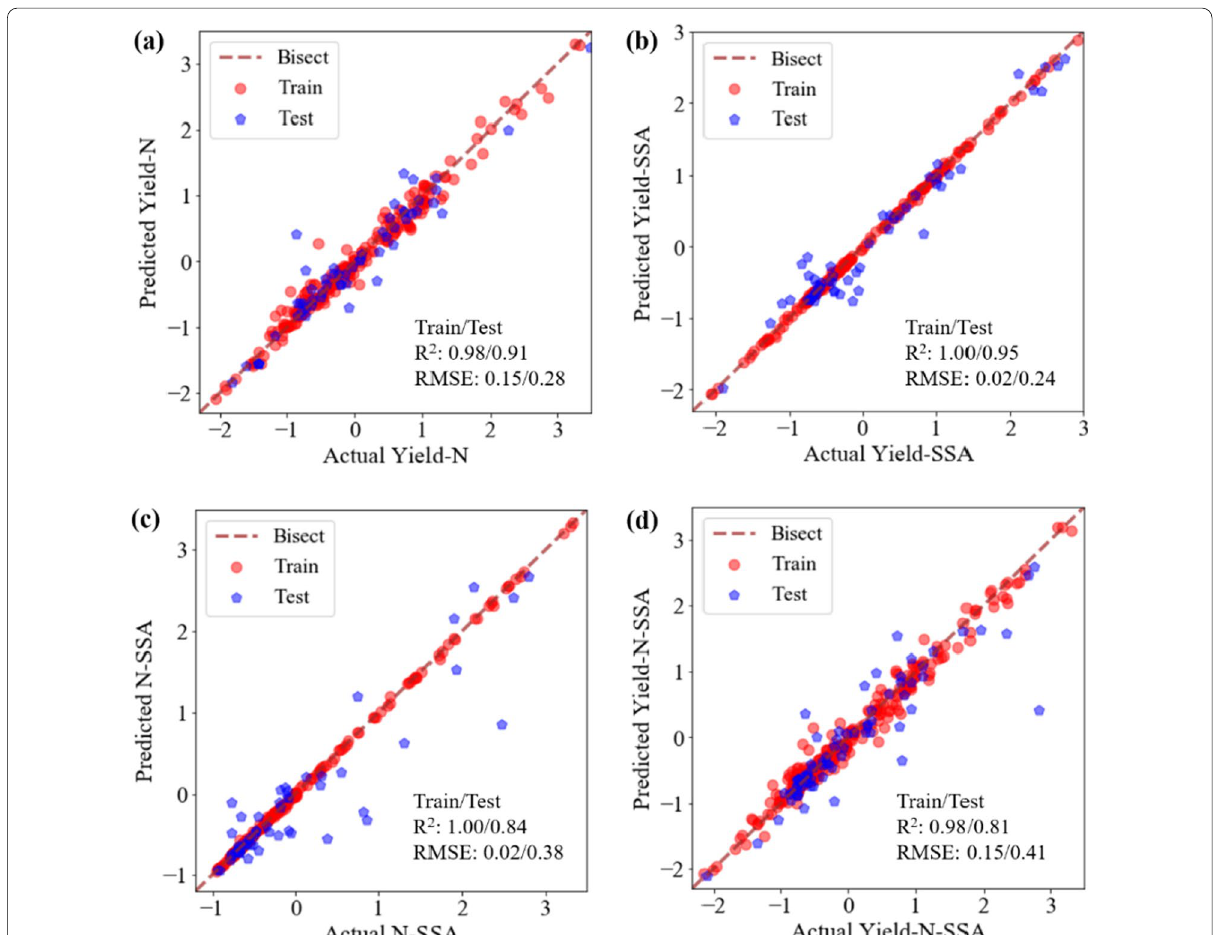
Fig. 5 Multi-target prediction figures based on GBR model for a Yield-char and N-char, b Yield-char and SSA-char, c N-char and SSA-char, and d Yield-char, N-char, and SSA-char from dataset #4_5, #5_5, #6_5, #7_5,